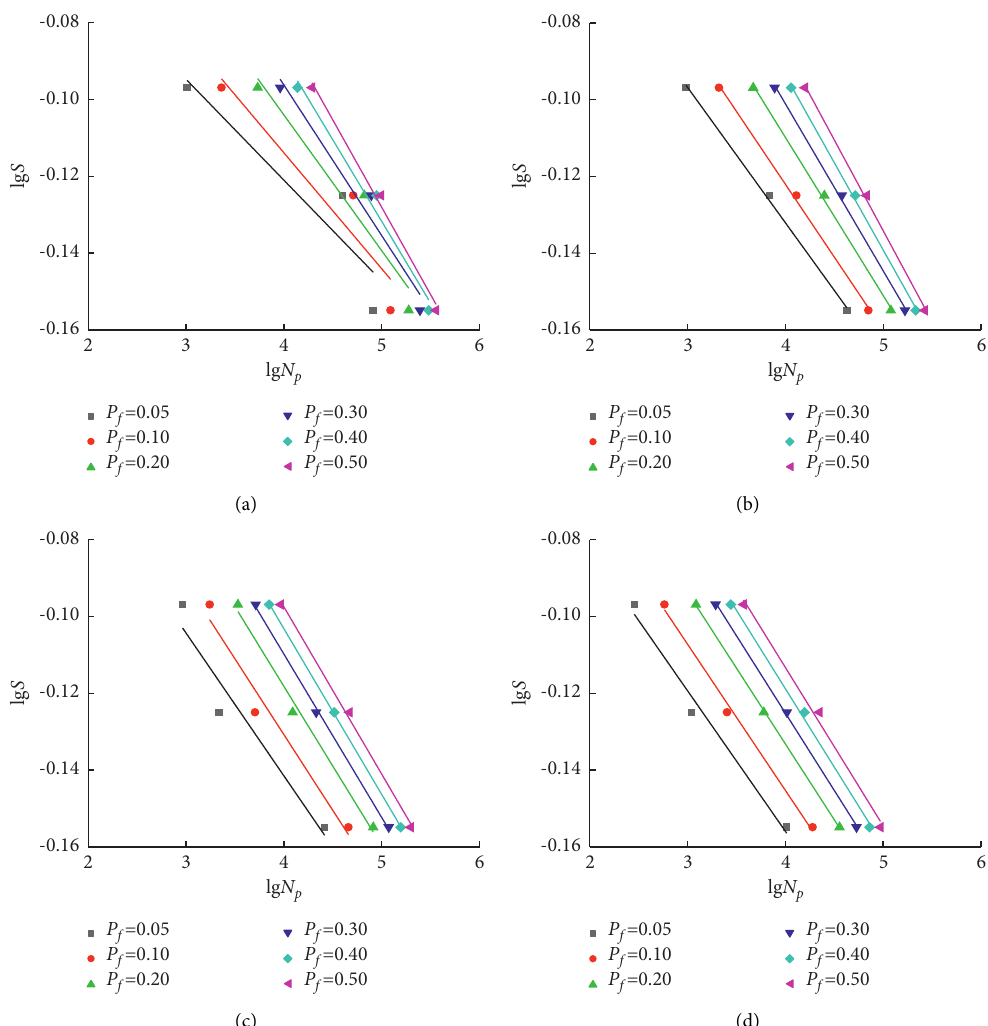
Figure 11: lg S –lgN relationships of AASC with various degrees of frost damage for various failure probabilities. (a) n � 0. (b) n � 50. (c) p n � 100. (d) n �